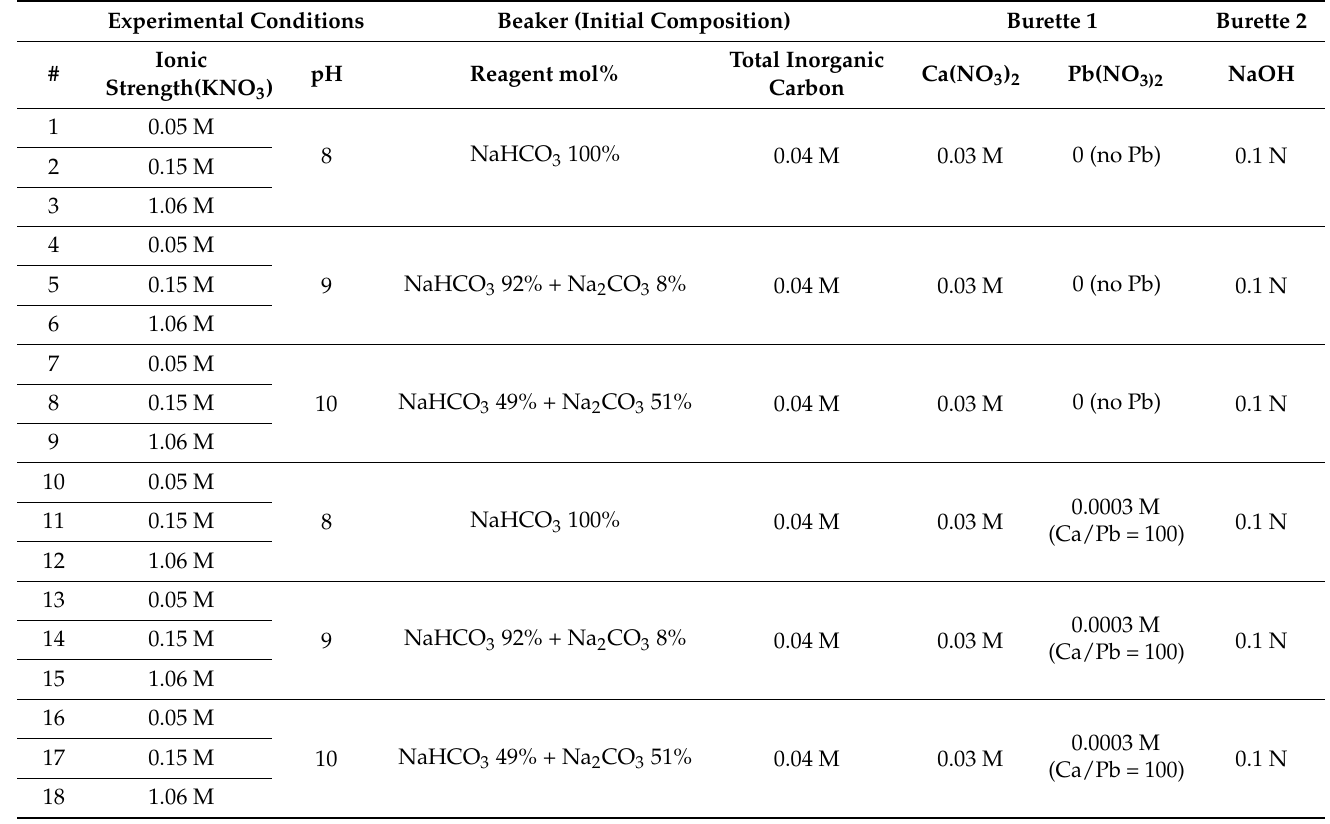
Table 1. Overview of the experimental conditions employed for the precipitation